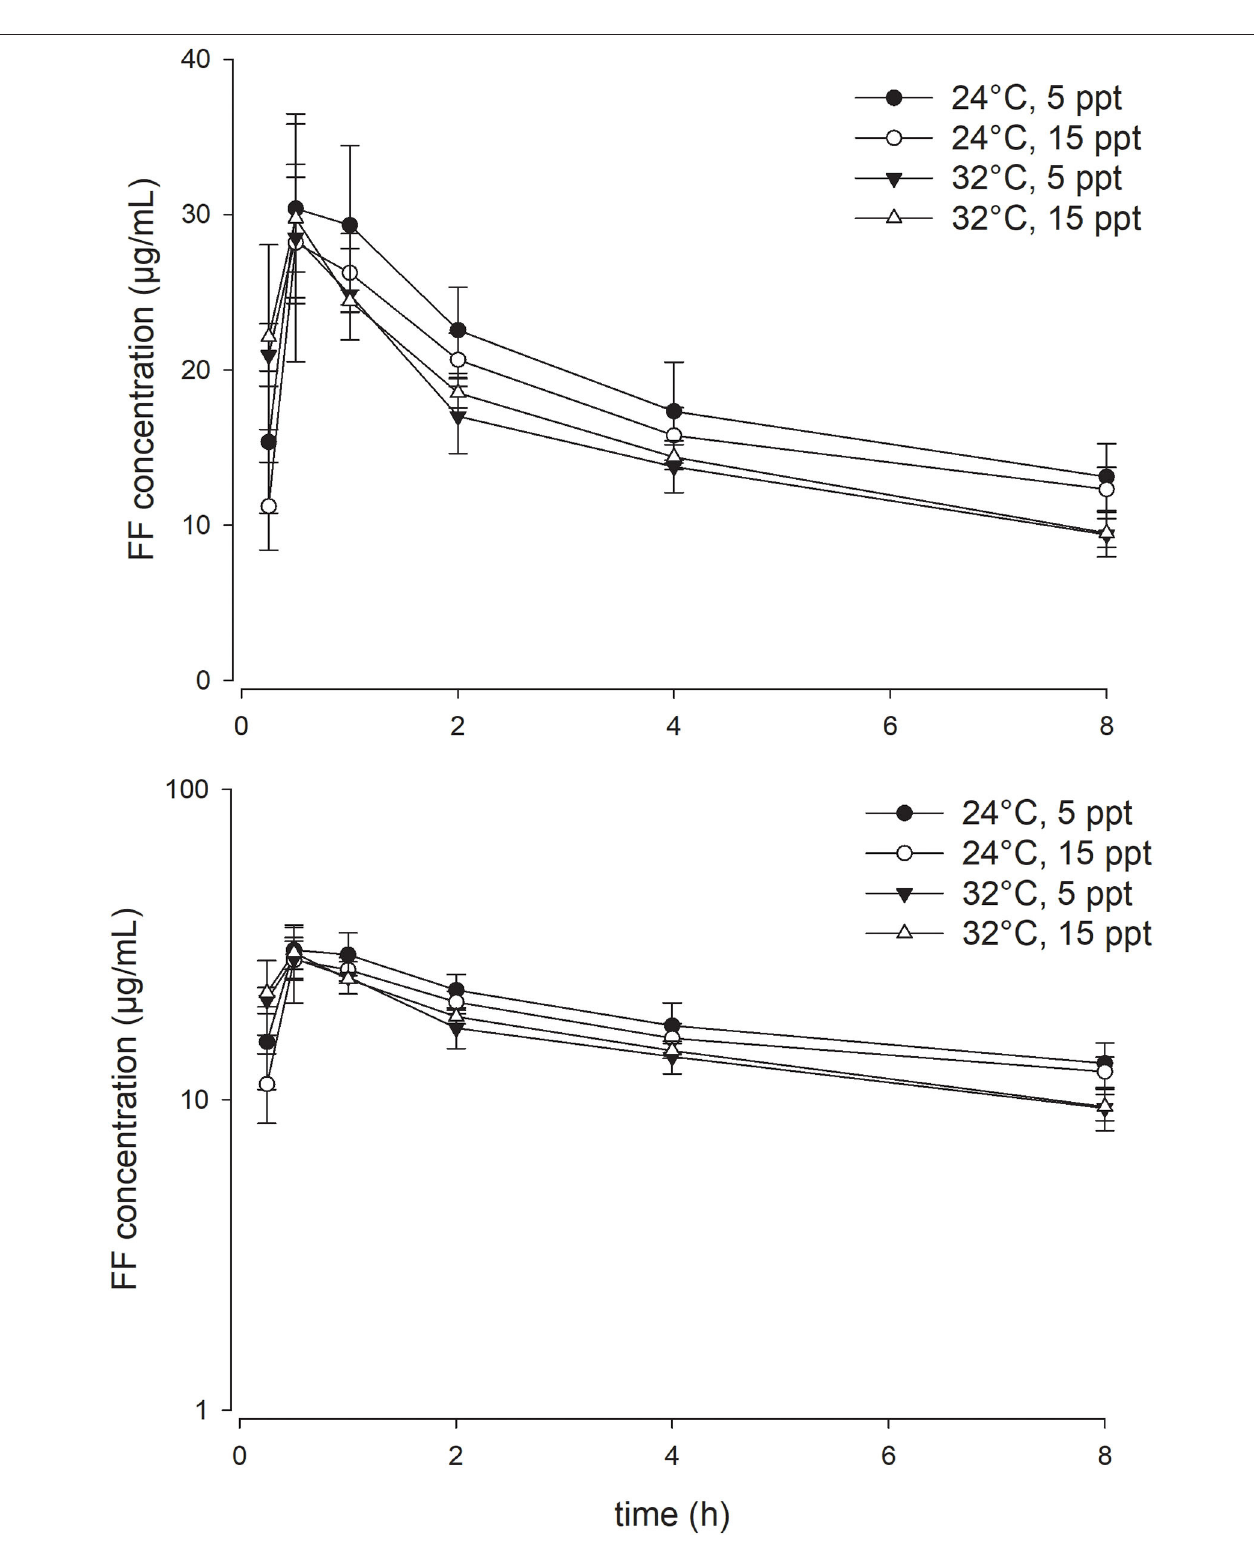
FIGURE 3 | Linear (above) and semi-logarithmic plots (below) of serum concentration-time profile during the first 8h (mean ± SD) of 15 mg/kg florfenicol following oral (PO) administration at two temperatures and two salinities ( n = 4 for the 32 ◦ C with 15 ppt group; n = 7 for the other three groups).